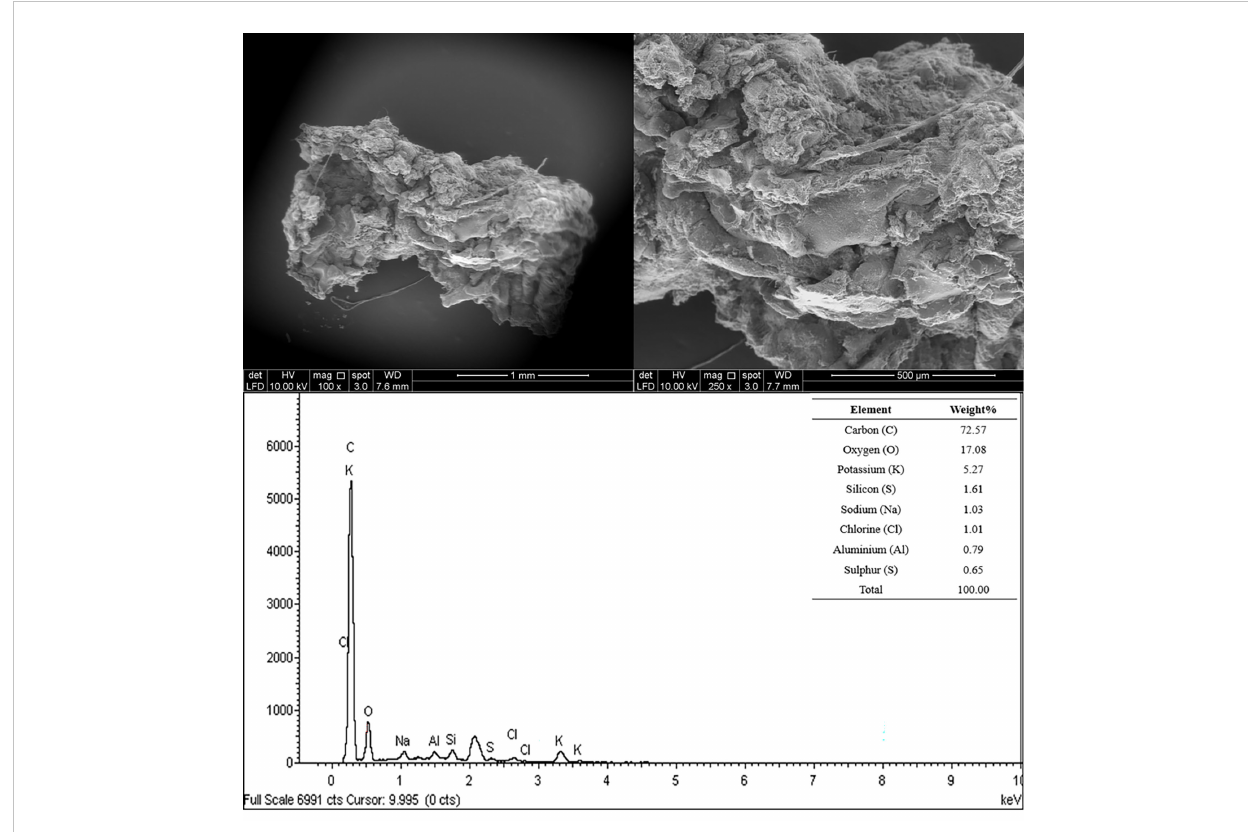
FIGURE 9 FESEM images of aged foam and the corresponding EDX spectra of aged foam recovered from the estuarine environment of